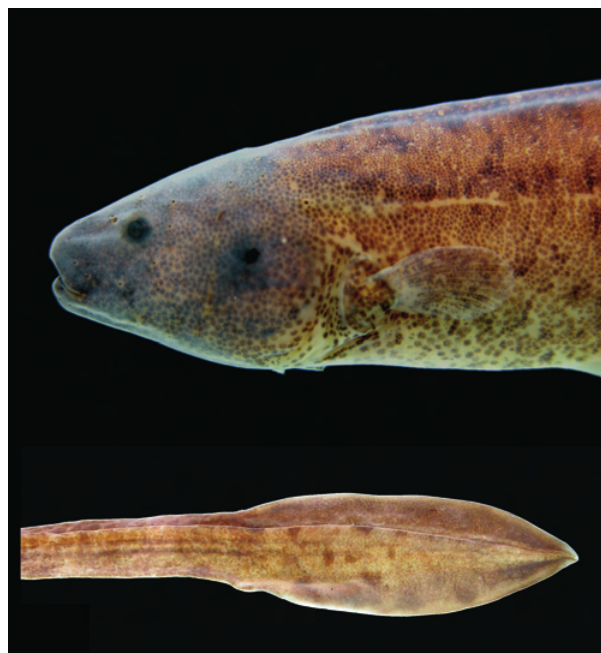
Fig. 2. Brachyhypopomus draco (holotype, MCP 41540, male, 137.3 mm LEA). Detailed images of head, above, and tail, be-